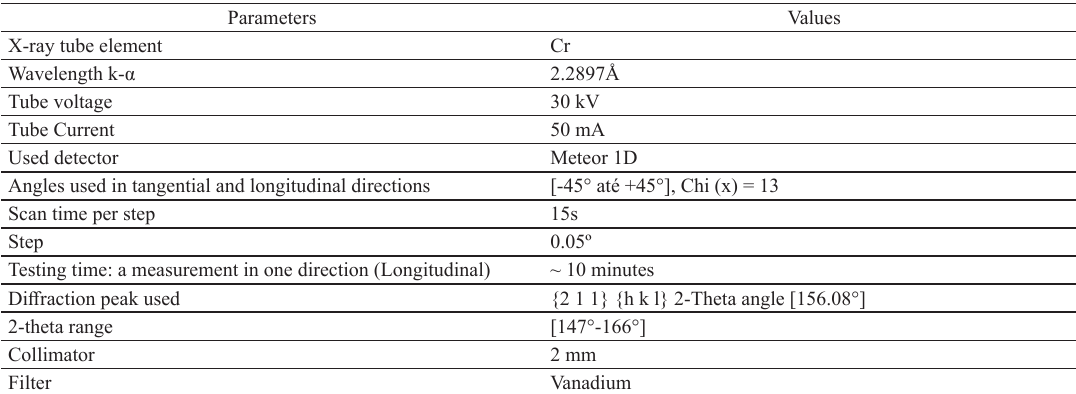
Table 4. Parameters used in the X-ray